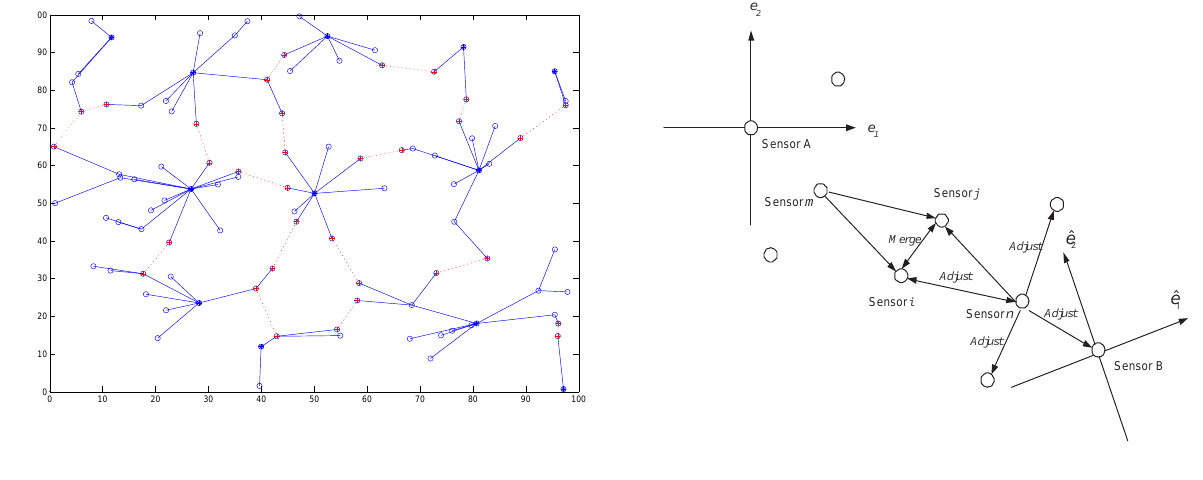
Figure 3. An example of the cluster formation with distributed border sensors (left); The process of merging clusters. The border sensors, sensor i and sensor j , communicate with each other by sending Merge messages in order to obtain adjustment information. Then sensor i transmits an Adjust signal to the sensors in the reoriented cluster